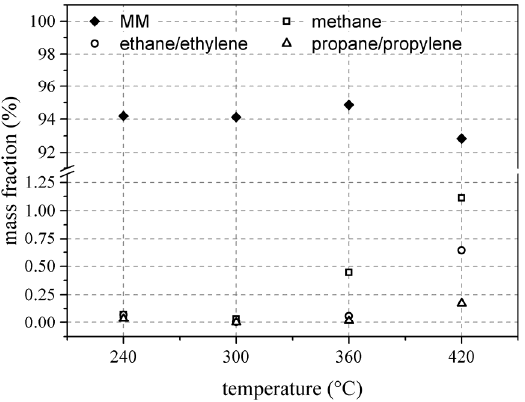
Figure 9. Mass fraction of MM, methane, ethane/ethylene and propane/propylene in the vapor phase after the experiment depending on temperature (test series: heating and instant cooling).